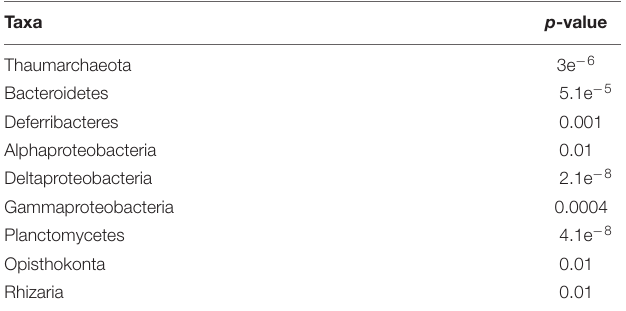
TABLE 2 | p -values for taxa showing significant relative abundance shifts between filter conditions and filtration